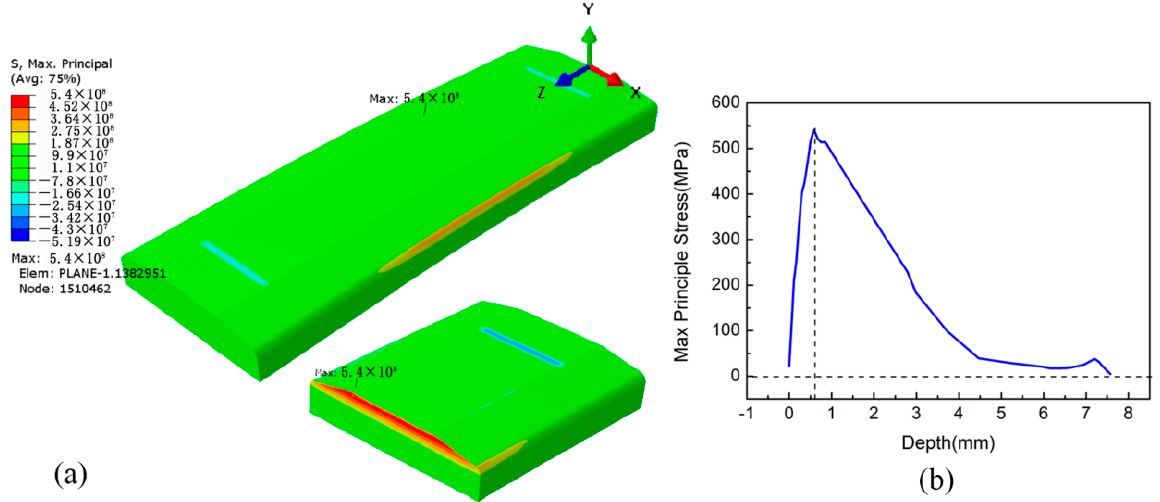
Figure 8. Maximum principal stress of the LSP-treated specimen subjected to four-point bending: ( a ) stress field distribution; ( b ) stress curve along the depth passing through node No. 1510462.